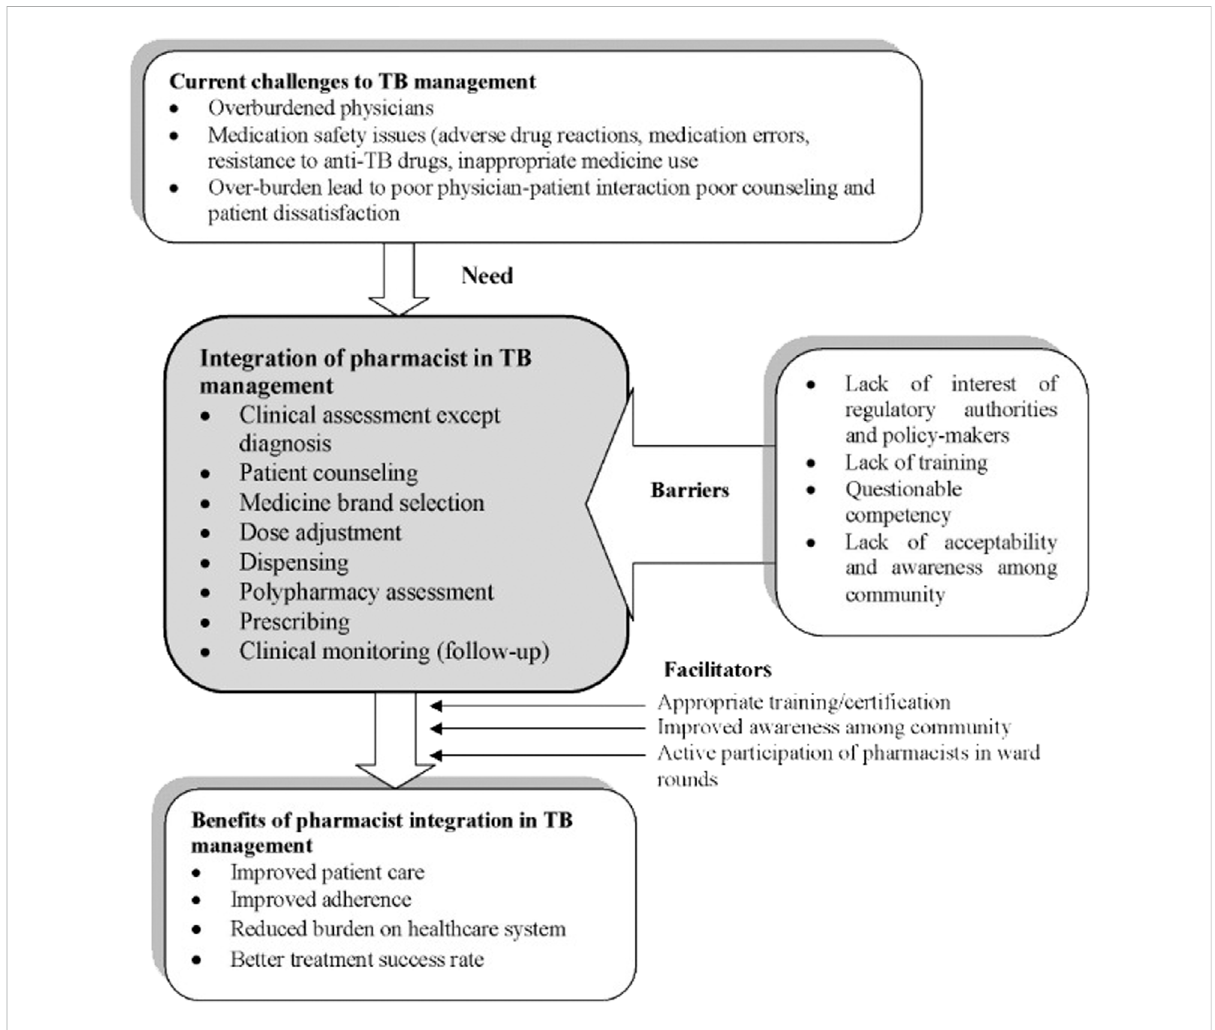
FIGURE 1 Summary of fi